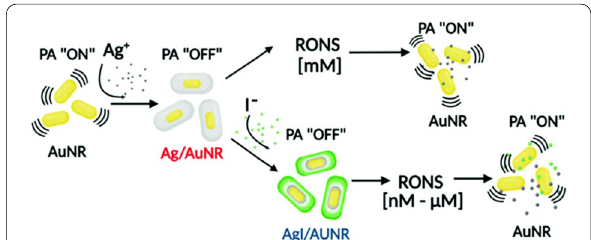
Fig. 8 Schematic of shell optimization. Schematic representation of the current work. Iodide doping results in biologically relevant [nM– μM] sensitivity to RONS. Adapted from Ref. [123] with permission. Copyright (2020), Royal Society of Chemistry